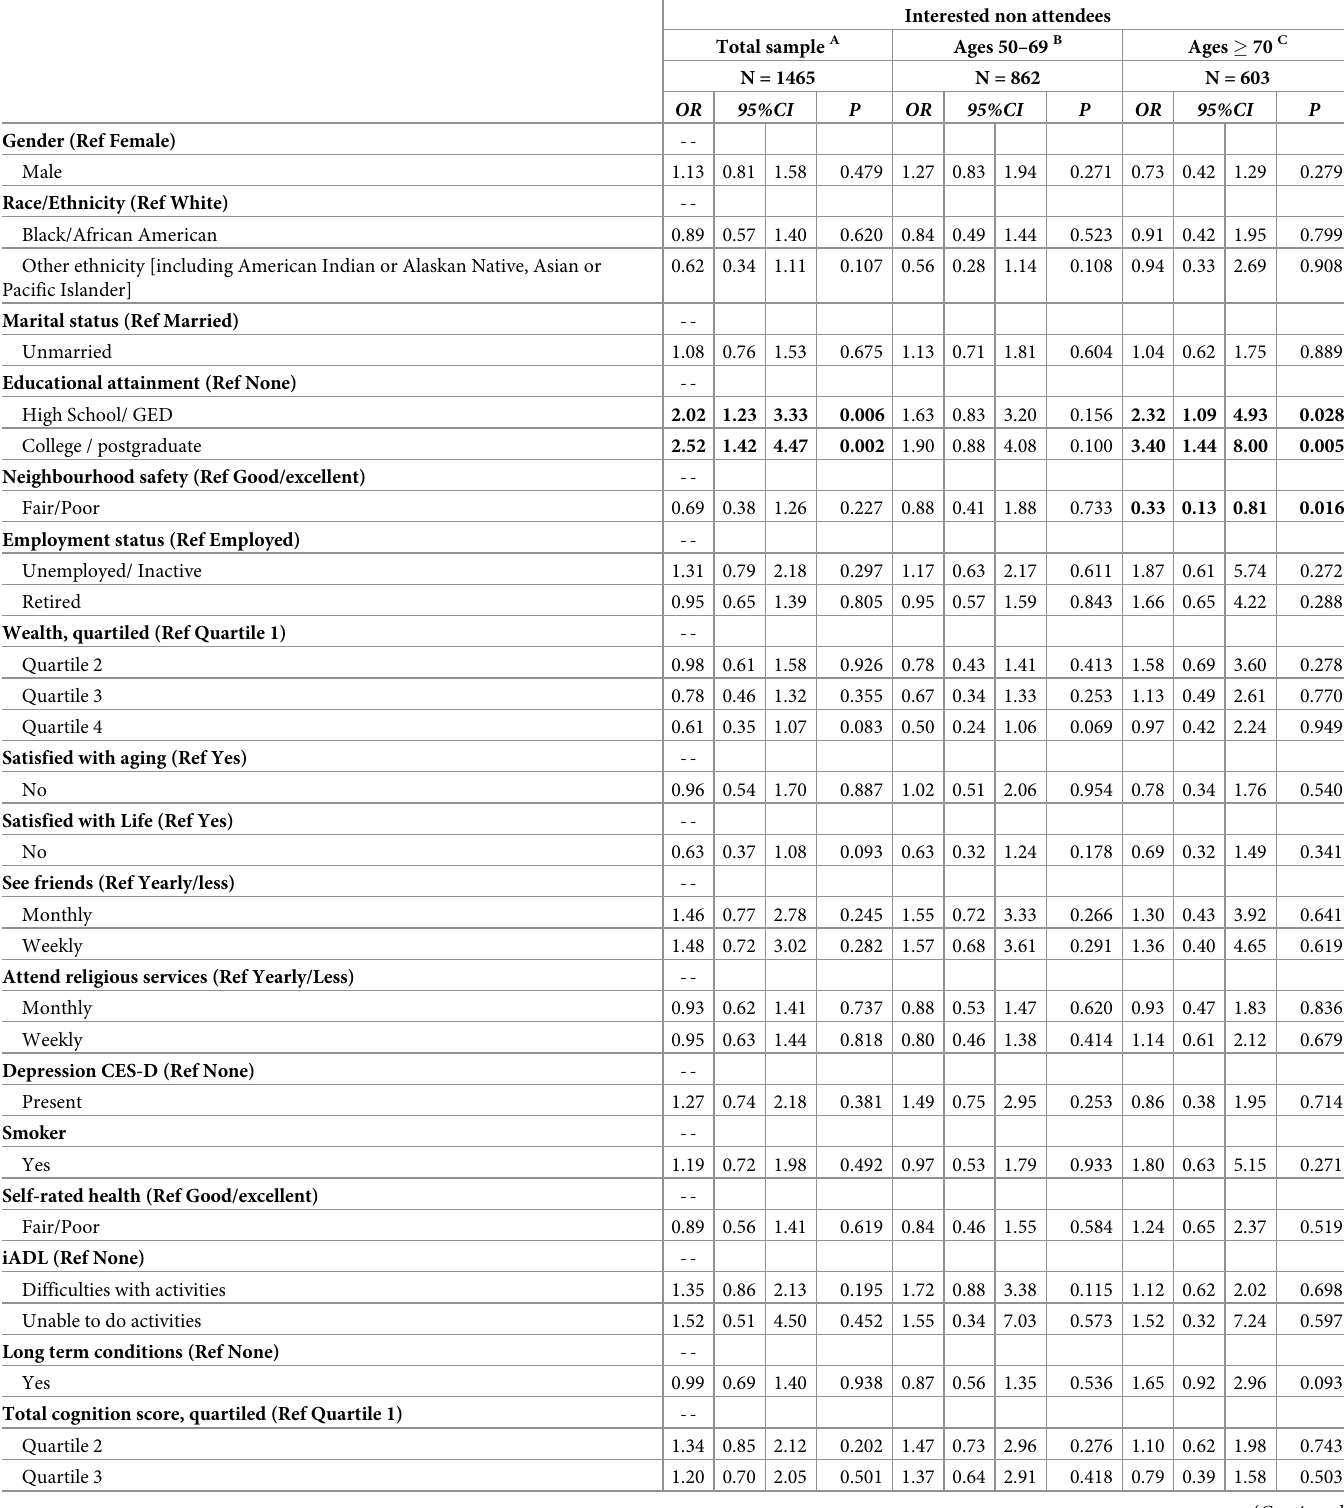
Table 4. Age related differences in predictors of interested non-attendees of cultural events in the past 12 months from logistic regression